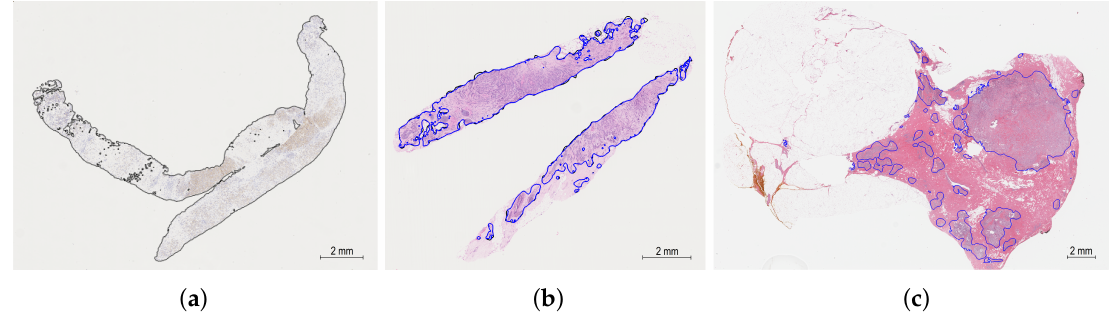
Figure 2. Image examples from used datasets: HER2SC [10] IHC stained slides ( a ), HER2SC [10] H&E stained slides ( b ), BRCA [11,12] H&E stained slides ( c ). The tile extraction was solely done on tissue, here denoted by the delineated